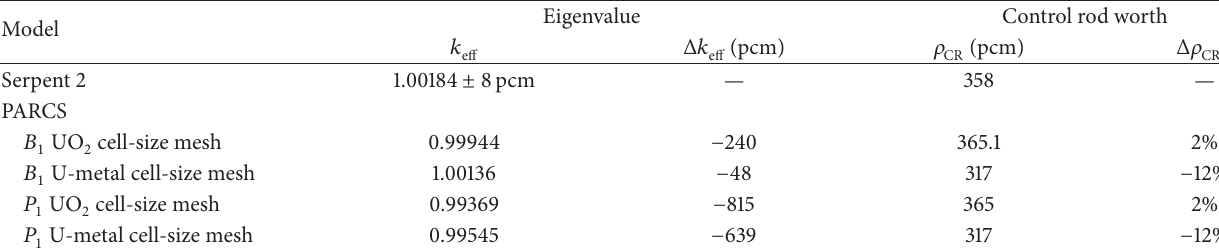
Table 1: 𝑘 and control rod reactivity worth benchmark results. eff